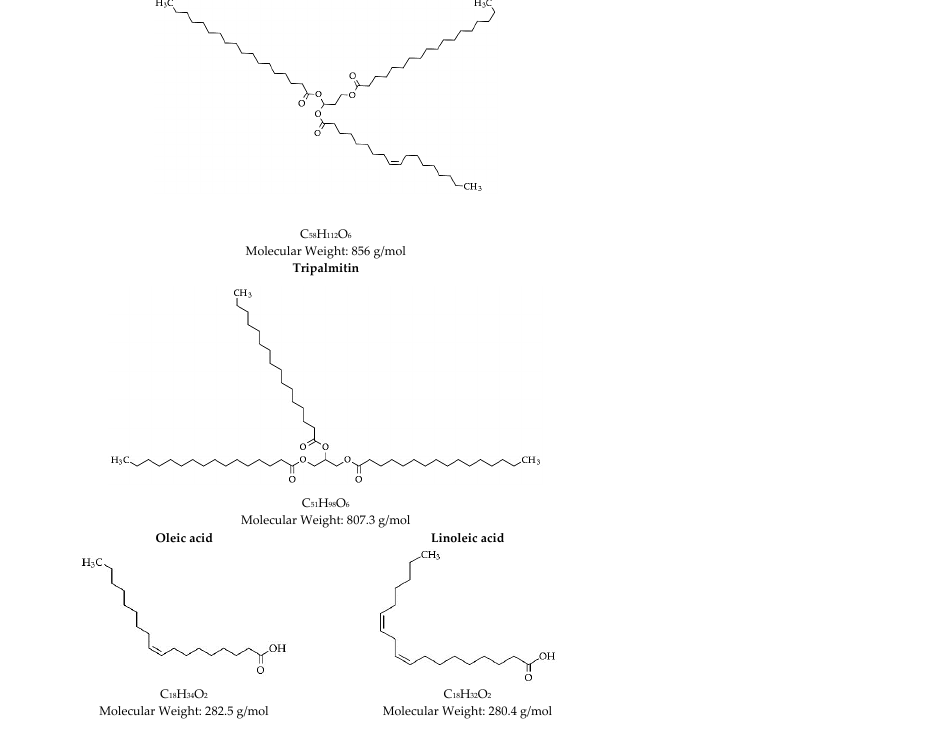
Figure 3. Chemical structures identified in the extract and fractions obtained from different parts of Platonia insignis Mart. There is excellent potential for bacuri to develop drugs of natural origin, which h ave added economic value to the fruit, including the inedible parts of the plant [52]. The antioxidant action observed in studies with different parts of the fruit and palm has been widely cited